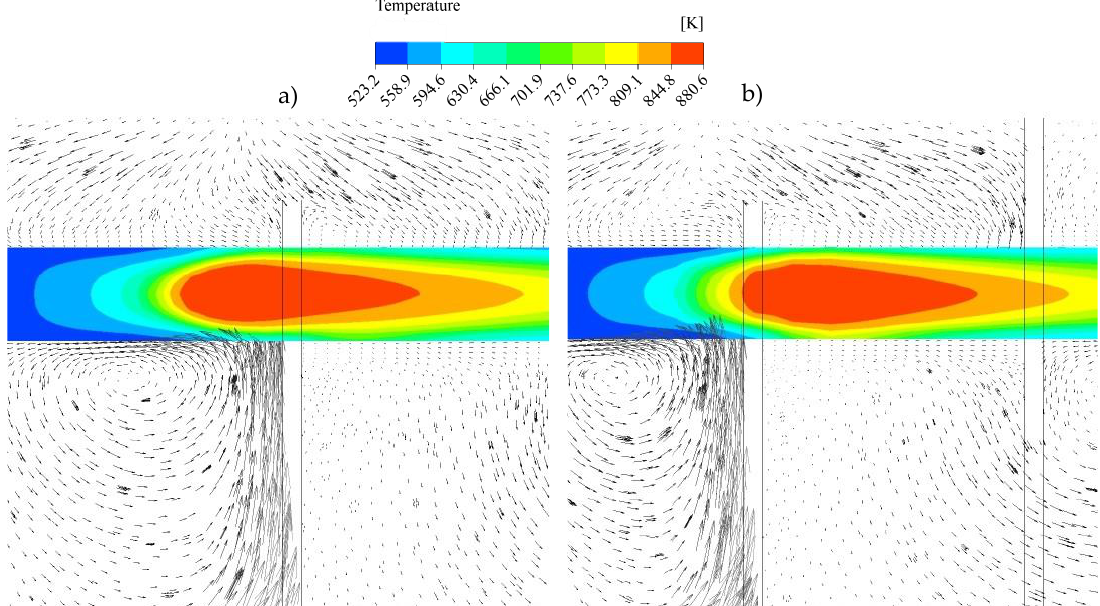
Figure 10. Hot spot detail at x = 0 cut plane, ( a ) baffle at hot spot position, ( b ) baffle positioned according to standards.